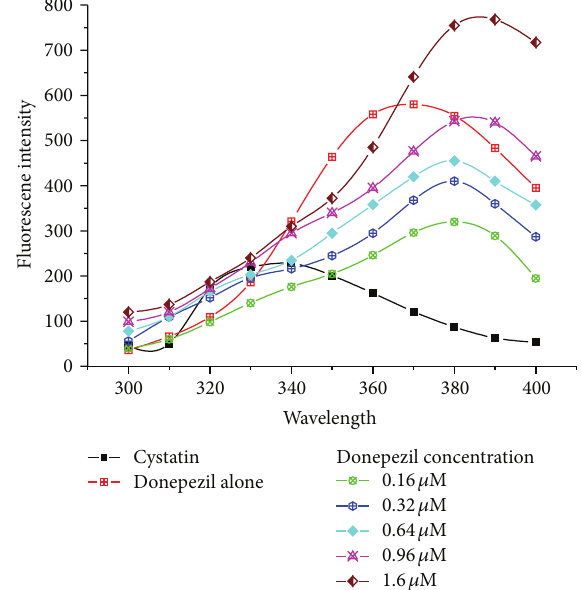
Figure 3: Fluorescence spectra of cystatin in the presence and absence of